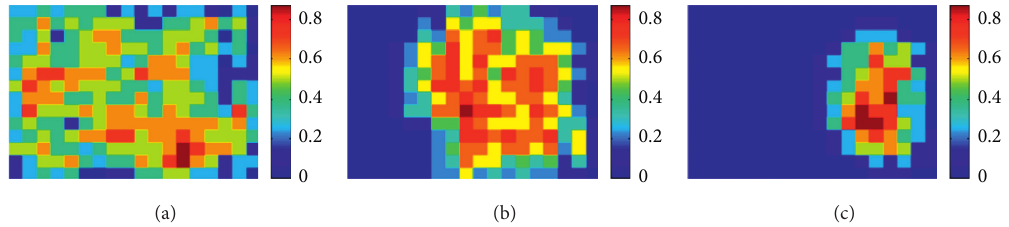
Figure 20: Diagram of personnel density of CA model at different times (unit: Δ t ). (a) T � 0. (b) T � 40. (c) T � 80.